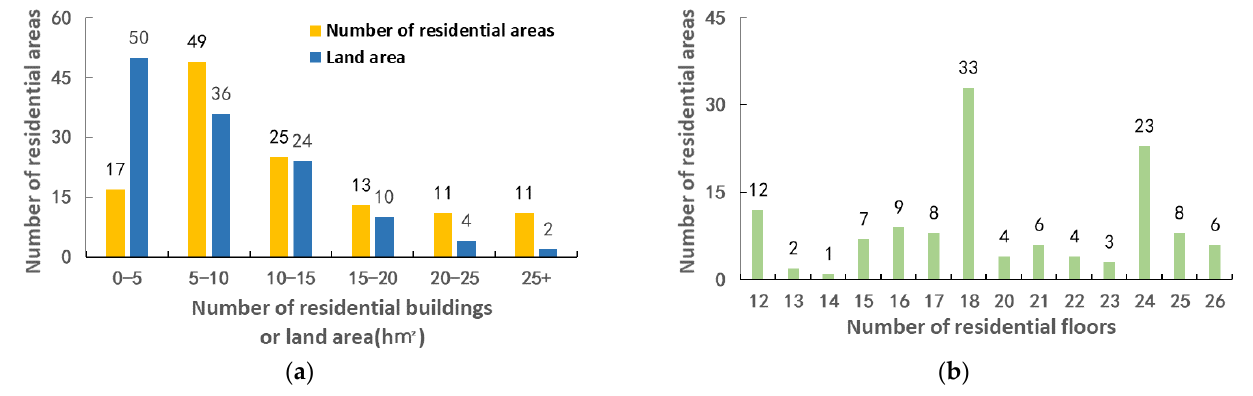
Figure 2. High-rise residential buildings in Harbin. ( a ) Distribution of land area and number of buildings and ( b ) distribution of height of buildings.